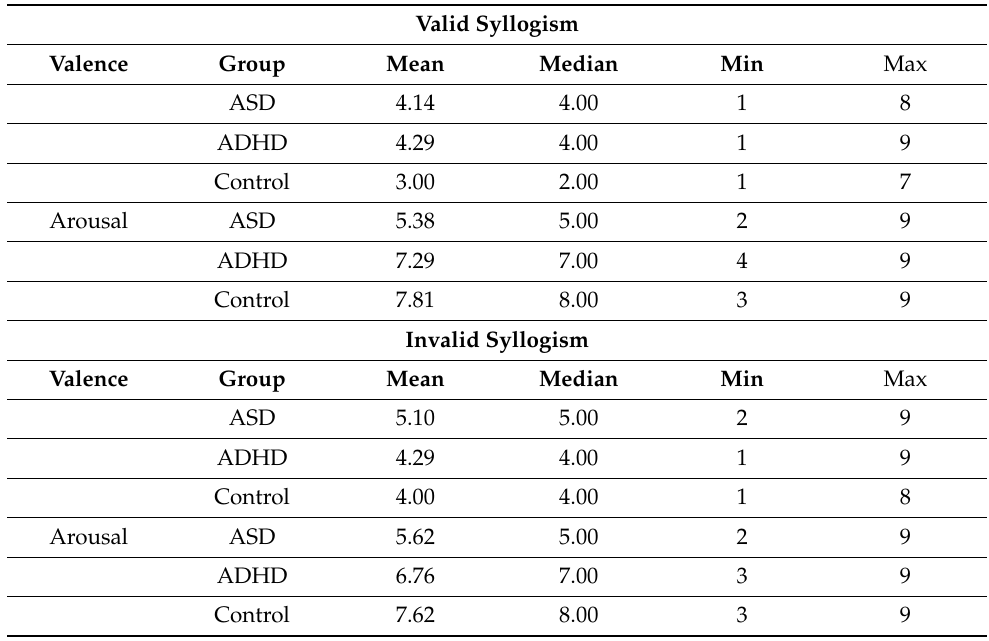
Table 8. Statistics of valence and arousal scores of participants that are used in plotting the 2-D circumplex model of affect, Figure 7c. Valid